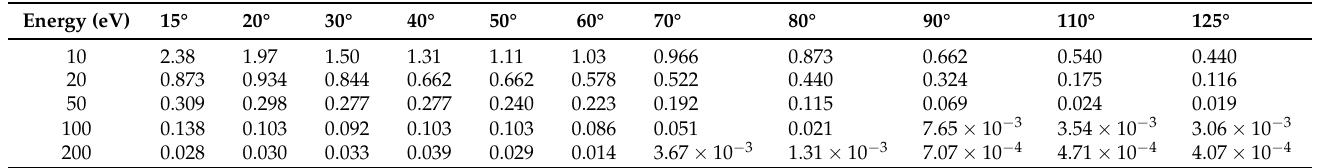
Table 2. DDCS data taken from the experiment of Lynch et al. [8] (scanned from Figure 6) in units of 10 − 18 cm 2 eV − 1 sr − 1 .